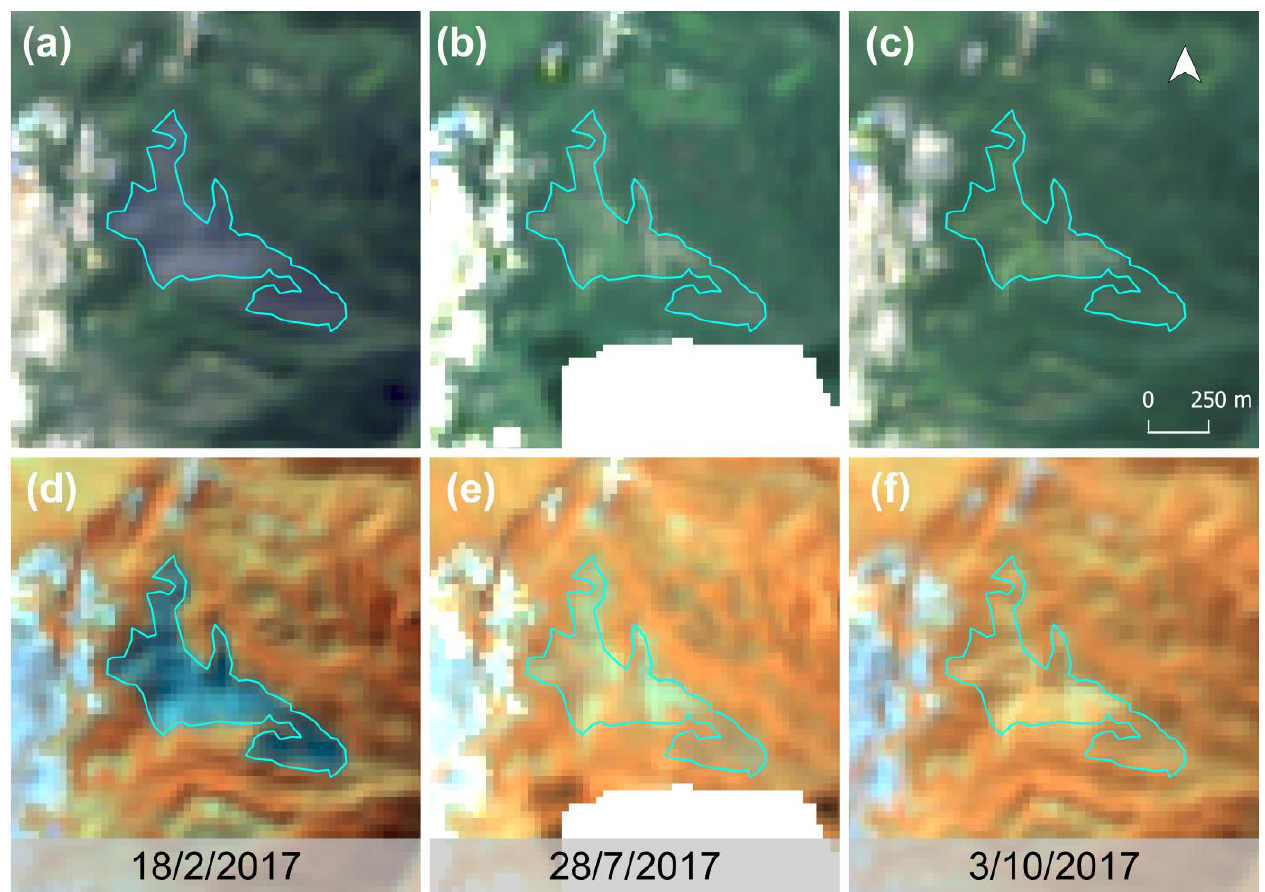
Figure 3. A burnt patch in degraded shrublands near Tai To Yan, Hong Kong (22°2 7′ 15.51 ″ N, 114° 6′ 12.55 ″ E) demonstrating the transient nature of local BAs. The fire broke out on 14 February 2017, according to Fire Service Department records, and was manually delineated on high-resolution Google Earth satellite imagery (light blue polygon). The patch was clearly visible on the Landsat scene captured shortly after the fire (18 February 2017) but rapidly revegetated and became undis- tinguishable after a few months (28 July 2017 and 3 October 2017). Panels ( a – c ) shows true colour RGB imagery recreated from the Landsat scenes, while panels ( d – f ) show NIR band as red, SWIR1 band as green, and SWIR2 band as blue. Note the importance of SWIR bands, which is used to calculate the normalized burn ratio (NBR), in enhancing the contrast of burnt patches.